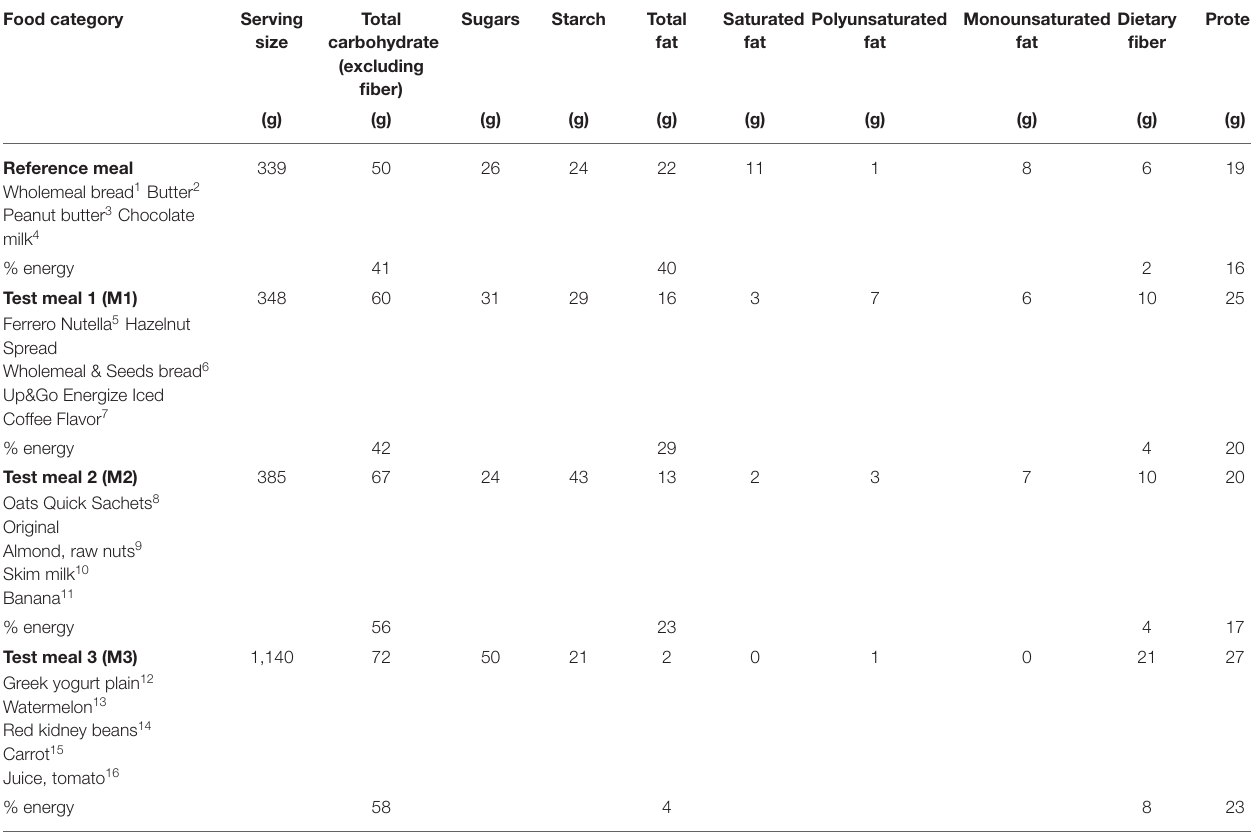
TABLE 1 | Macronutrient composition of test meals and reference meal. Food category Serving